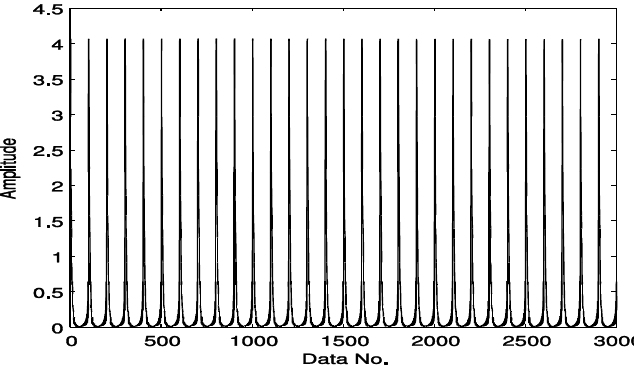
Figure 2. A simulated vibration signal induced by ( a ) outer race faults and ( b ) a typical section with four cycles within the red box in ( a ) is shown from zoom-in view.